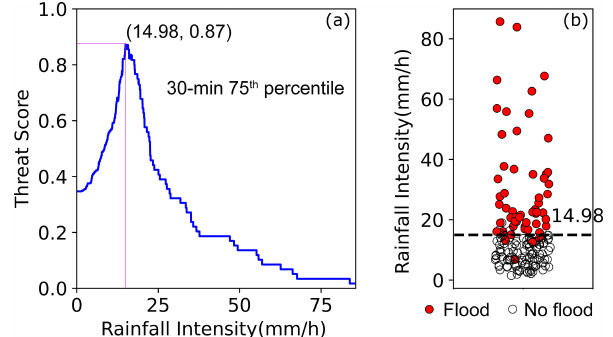
Figure 5. Threat score (TS) of the peak 75th percentile of I 30 in post-fire year 1. (a) Relationship between rainfall intensity and TS; (b) Scatter plots of positive (flood, red circle) and negative (no flood, hollow circle) with the rainfall intensity associated with the maximum